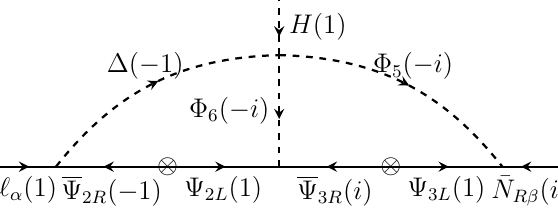
Figure 4 . Two loop Feynman diagram that generates the Dirac neutrino mass term e(cid:11)ectively. Here (cid:11) = 1 ; 2 ; 3 and (cid:12) = 1 ; 2. After softly breaking Z 4 the Majorana mass terms of (4.5) should be included, thus giving rise to an e(cid:11)ective seesaw neutrino mass, see (cid:12)gure 5.